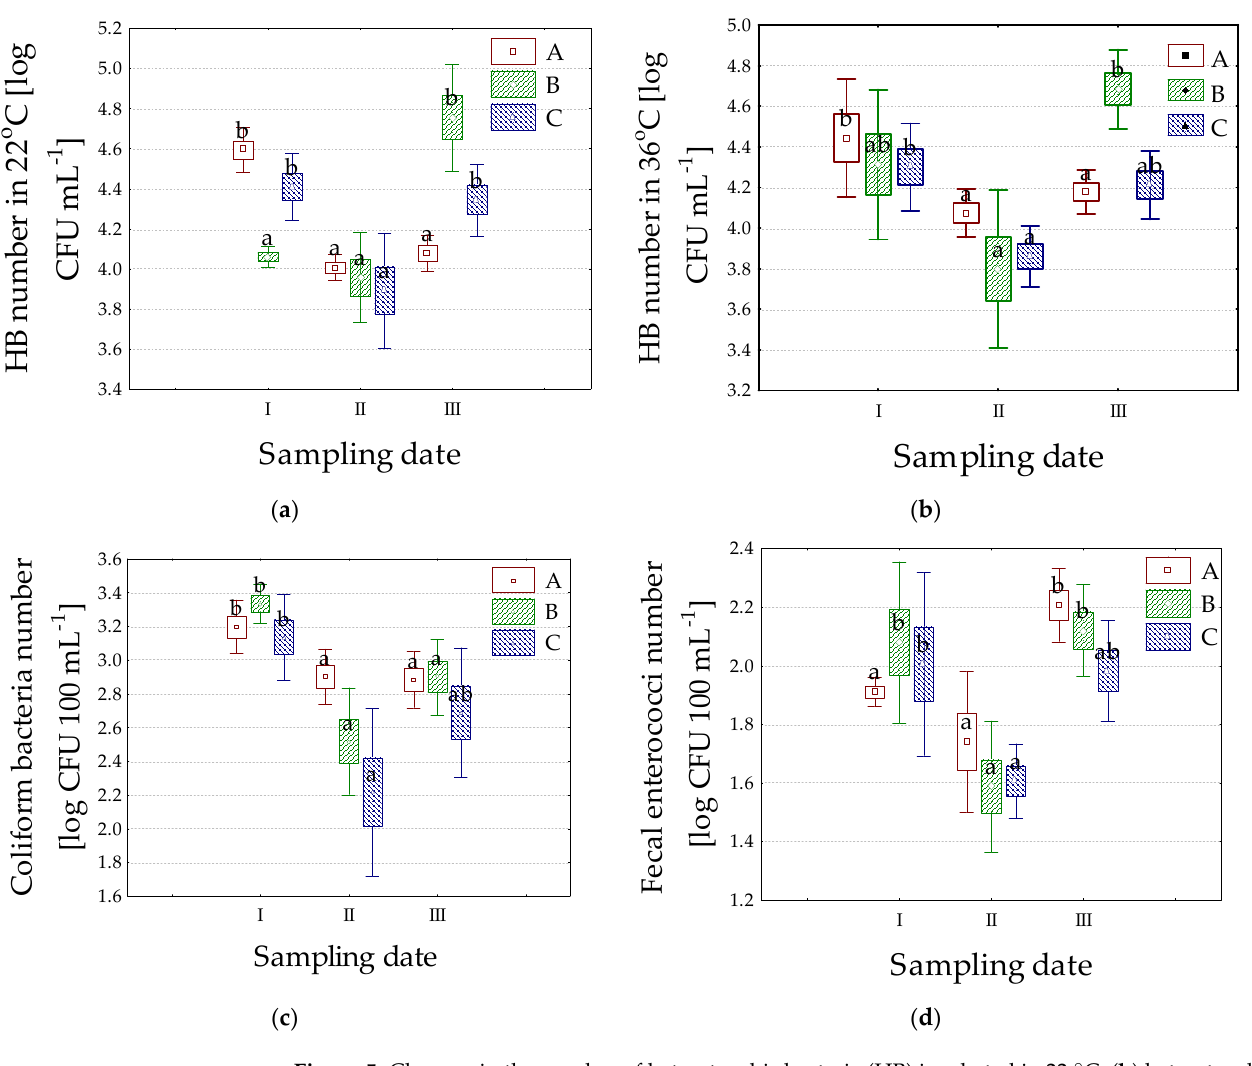
Figure 5. Changes in the number of heterotrophic bacteria (HB) incubated in 22 °C, ( b ) heterotrophic bacteria (HB) incubated in 36 °C, ( c ) coliform bacteria number and ( d ) fecal enterococci number in water samples in successive dates of sampling in three measurement points (A, B, C). Different letters (a, b, c) indicate statistically significant differences among sampling dates.